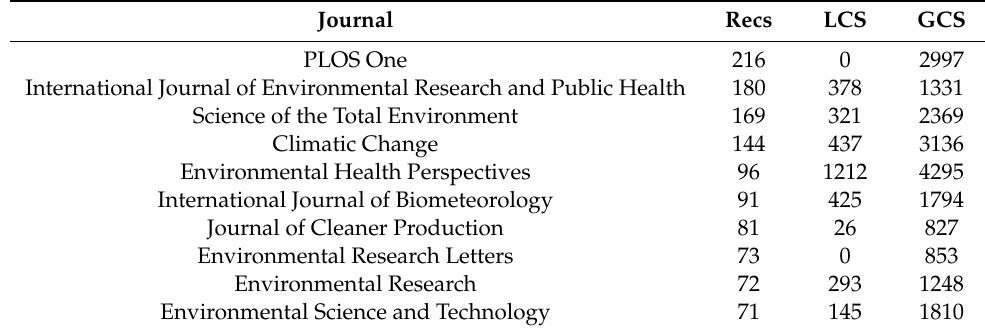
Table 4. Top 10 journals with the most published